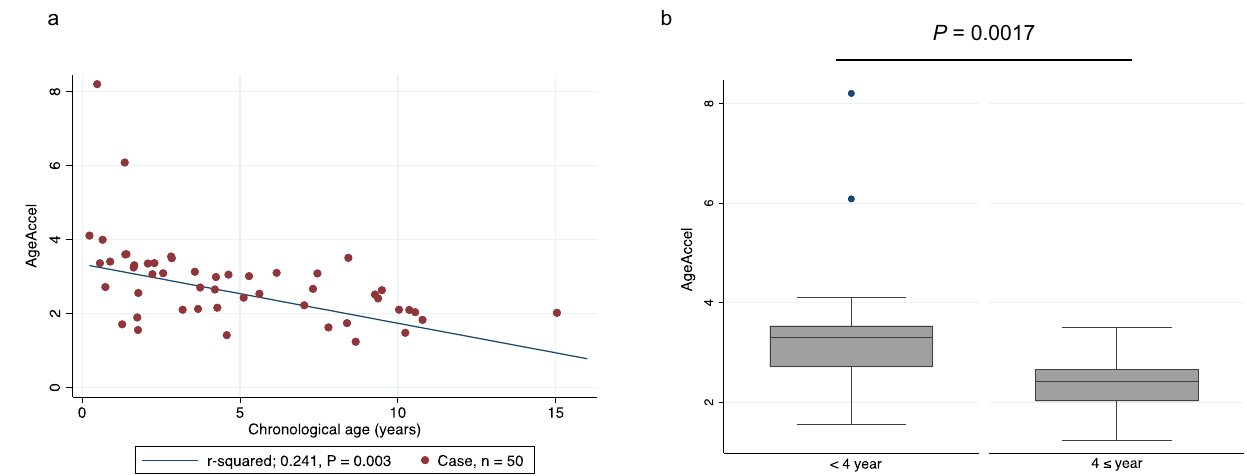
Figure 2. AgeAccel by time post-transplant. ( a ) The relationship between AgeAccel and chronological age was negatively correlated in cord blood transplant cases, but AgeAccel was still doubled in cases more than 10 years post-transplantation. ( b ) Cases were stratified into two groups by sample time, using a cut-off of 4 years post- transplant (the median elapsed time after transplantation), and the mean values for AgeAccel were compared using Student’s t-test. The mean AgeAccel for the group less than 4 years post-transplantation was 3.33 (95% CI, 2.77–3.90), significantly higher than the mean AgeAccel for the 4 years or more after transplantation group, which was 2.34 (95% CI, 2.09–2.59) ( P =